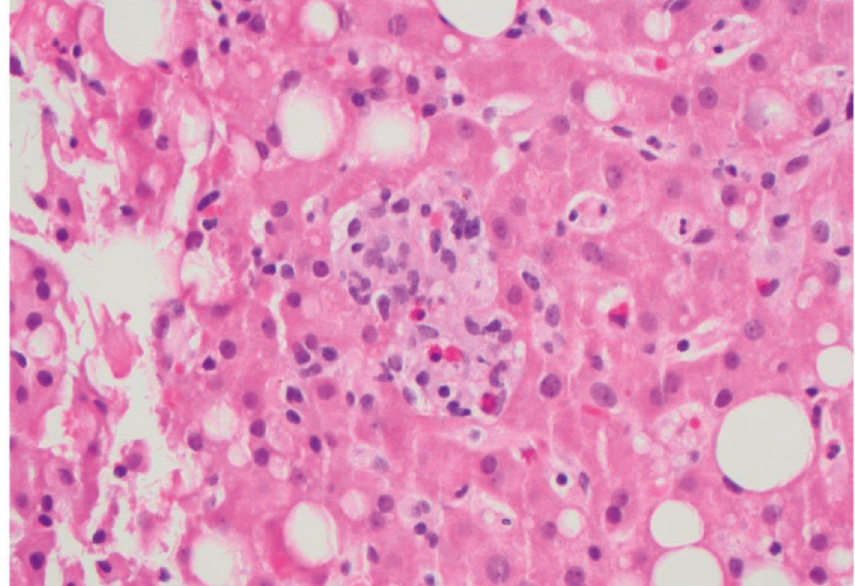
Figure 2: Lobular microgranuloma in the liver. H&E stain of liver tissue. Original magnification,